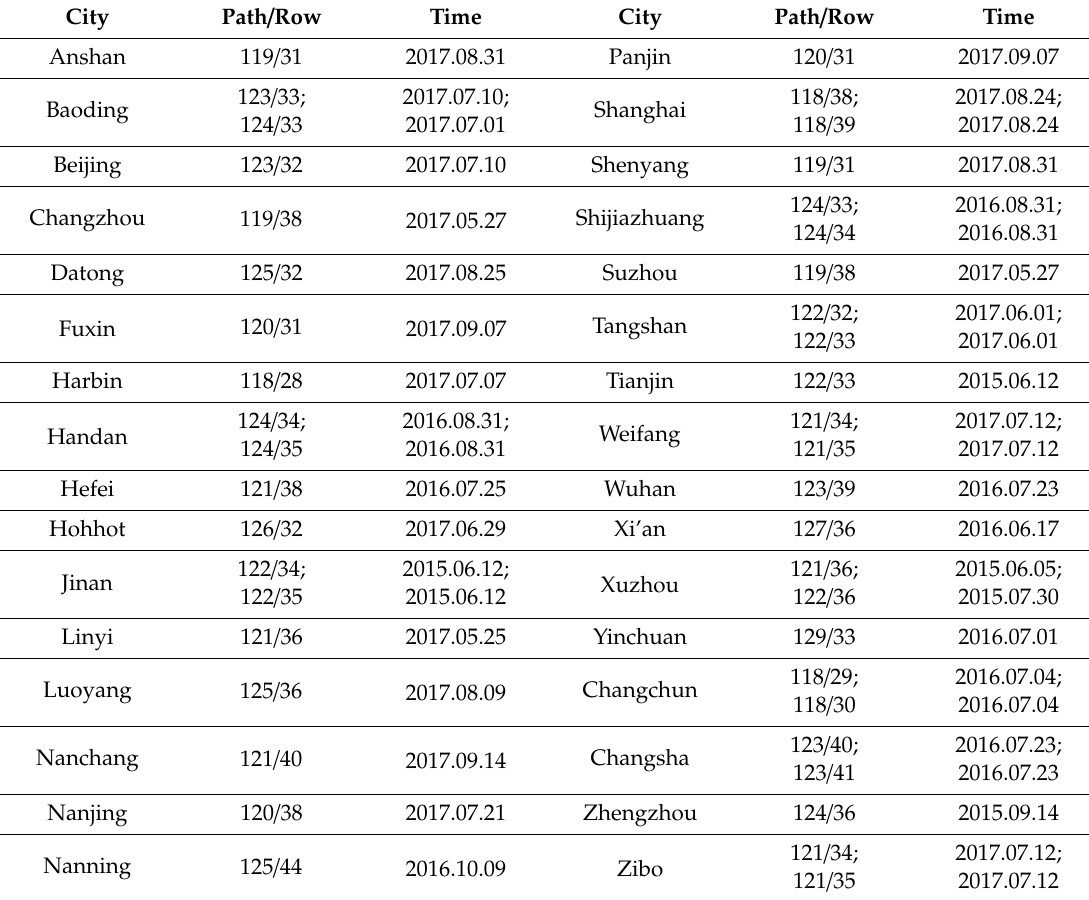
Table A1. List of the cities and the path / row numbers and the time of the Landsat 8 images each city